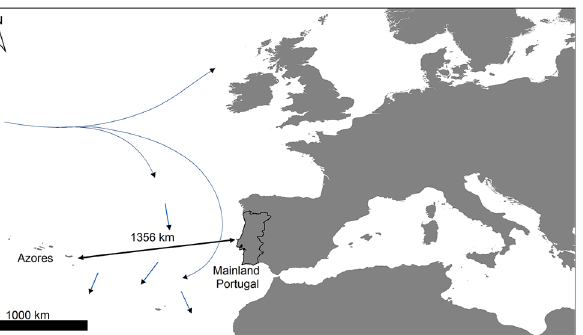
Fig 1. Global position of the archipelago of the Azores in relation to Europe. Map of the Azores, Europe, and the main oceanic current systems in the North Atlantic (36 – 39°N, 25 – 31°W).